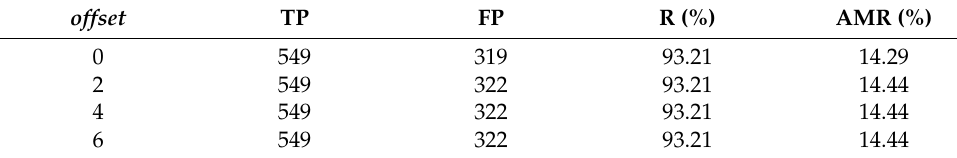
Table 1. Comparison of different of fset values in the integrated detector.